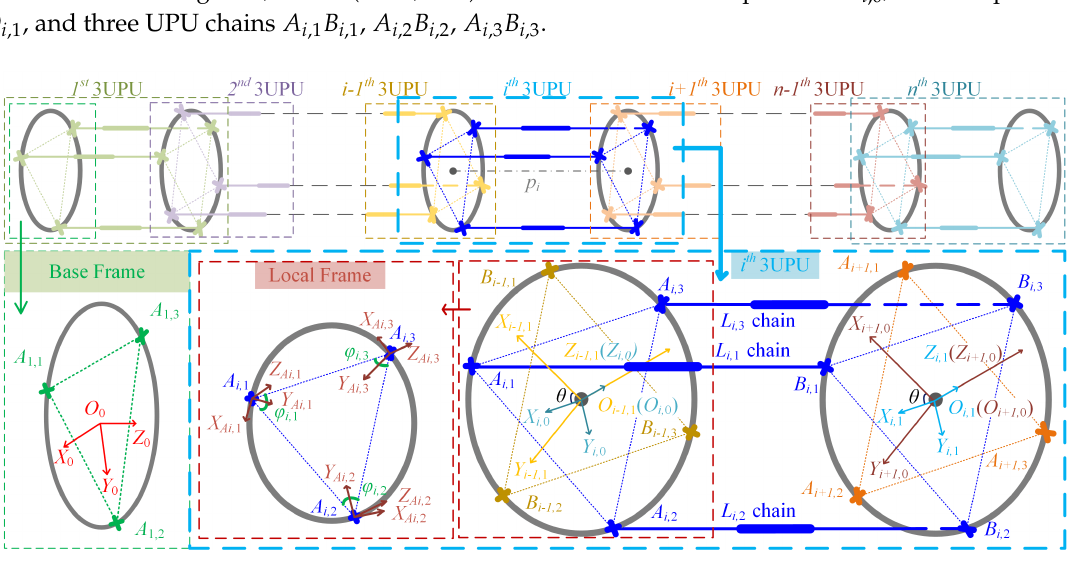
Figure 2. Schematics for the kinematic modeling of the EV charging robot consisting of n units of 3UPU